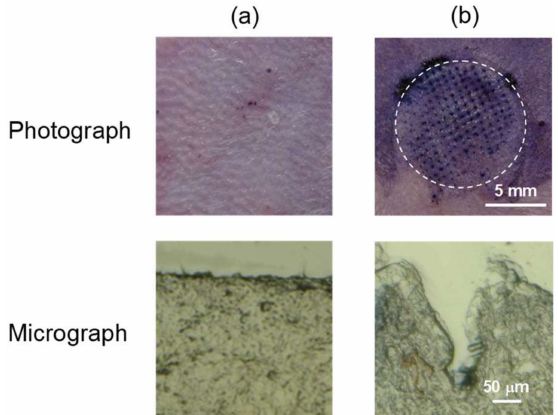
Figure 3. Photograph and micrograph of rat skin following application of human parathyroid hormone (1-34) (PTH)-loaded microneedle arrays (MNs). ( a ) Untreated and ( b ) PTH-loaded MNs.